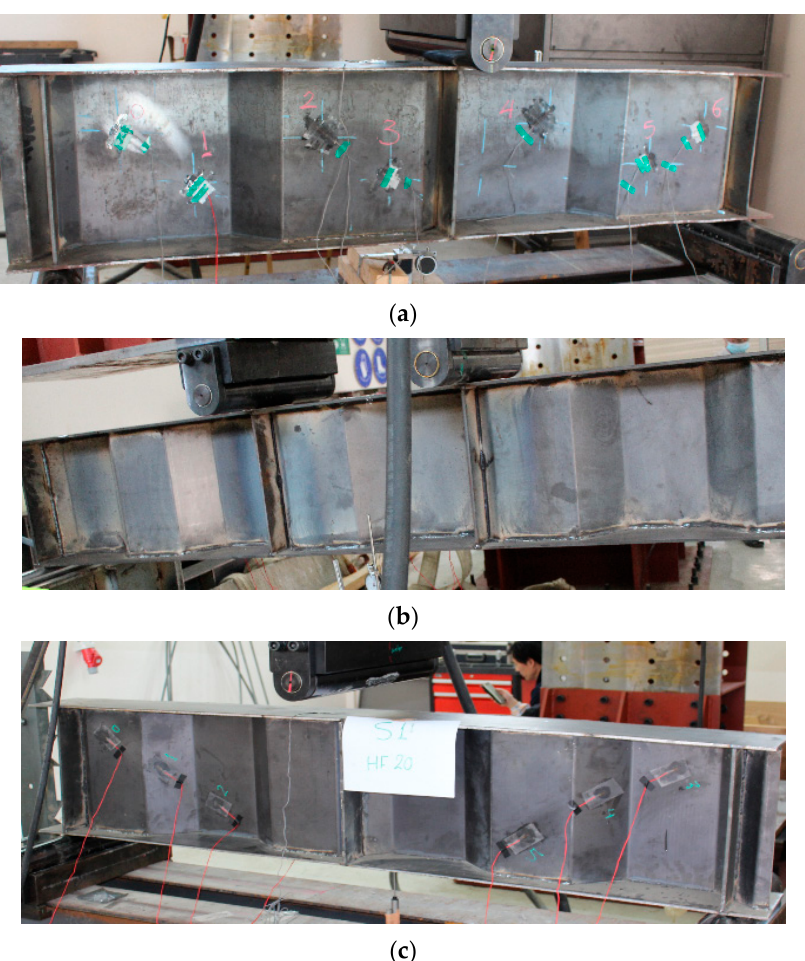
Figure 3. Sample of SBCW specimens: ( a ) Specimen 3PCW350, ( b ) Specimen 4PCW275 and ( c ) Specimen 3PCW200.